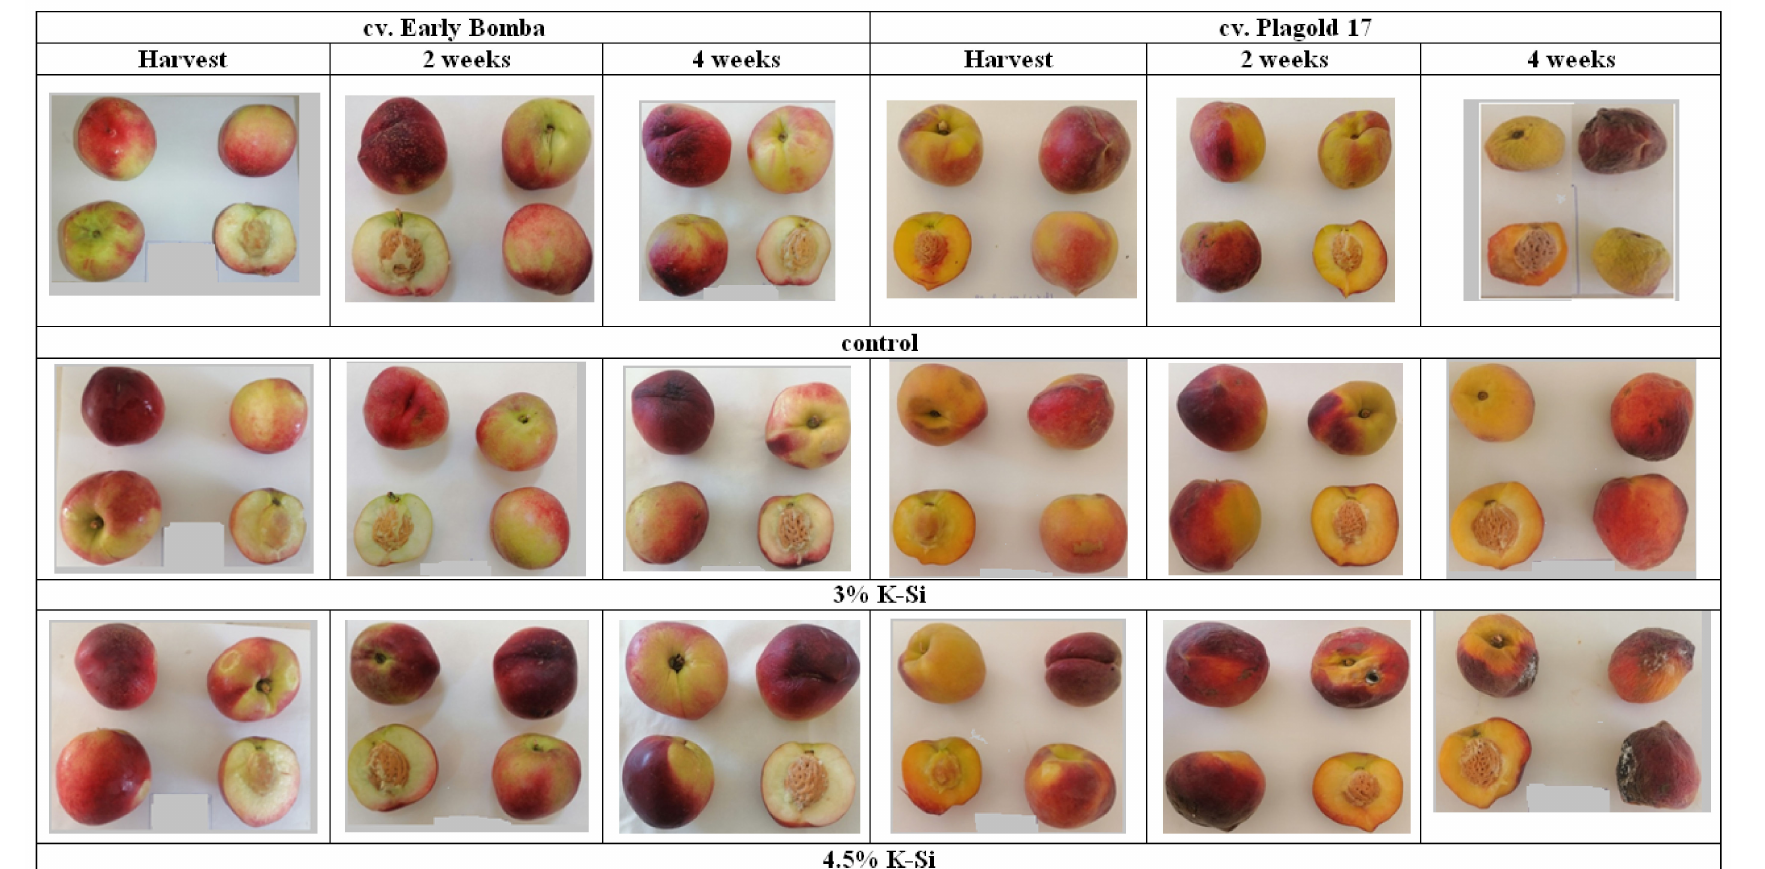
Figure 4. Impact of potassium silicon pretreatment and storage period on fruit decay in peach cultivars after 2 or 4 weeks of cold